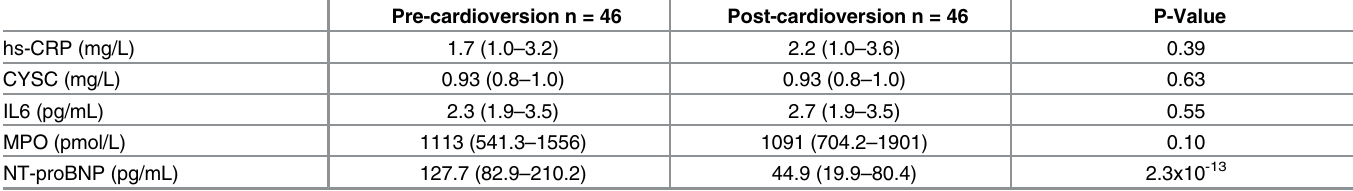
Table 3. Plasma biomarker concentrations in participants pre- and post-cardioversion. Data are medians (interquartile